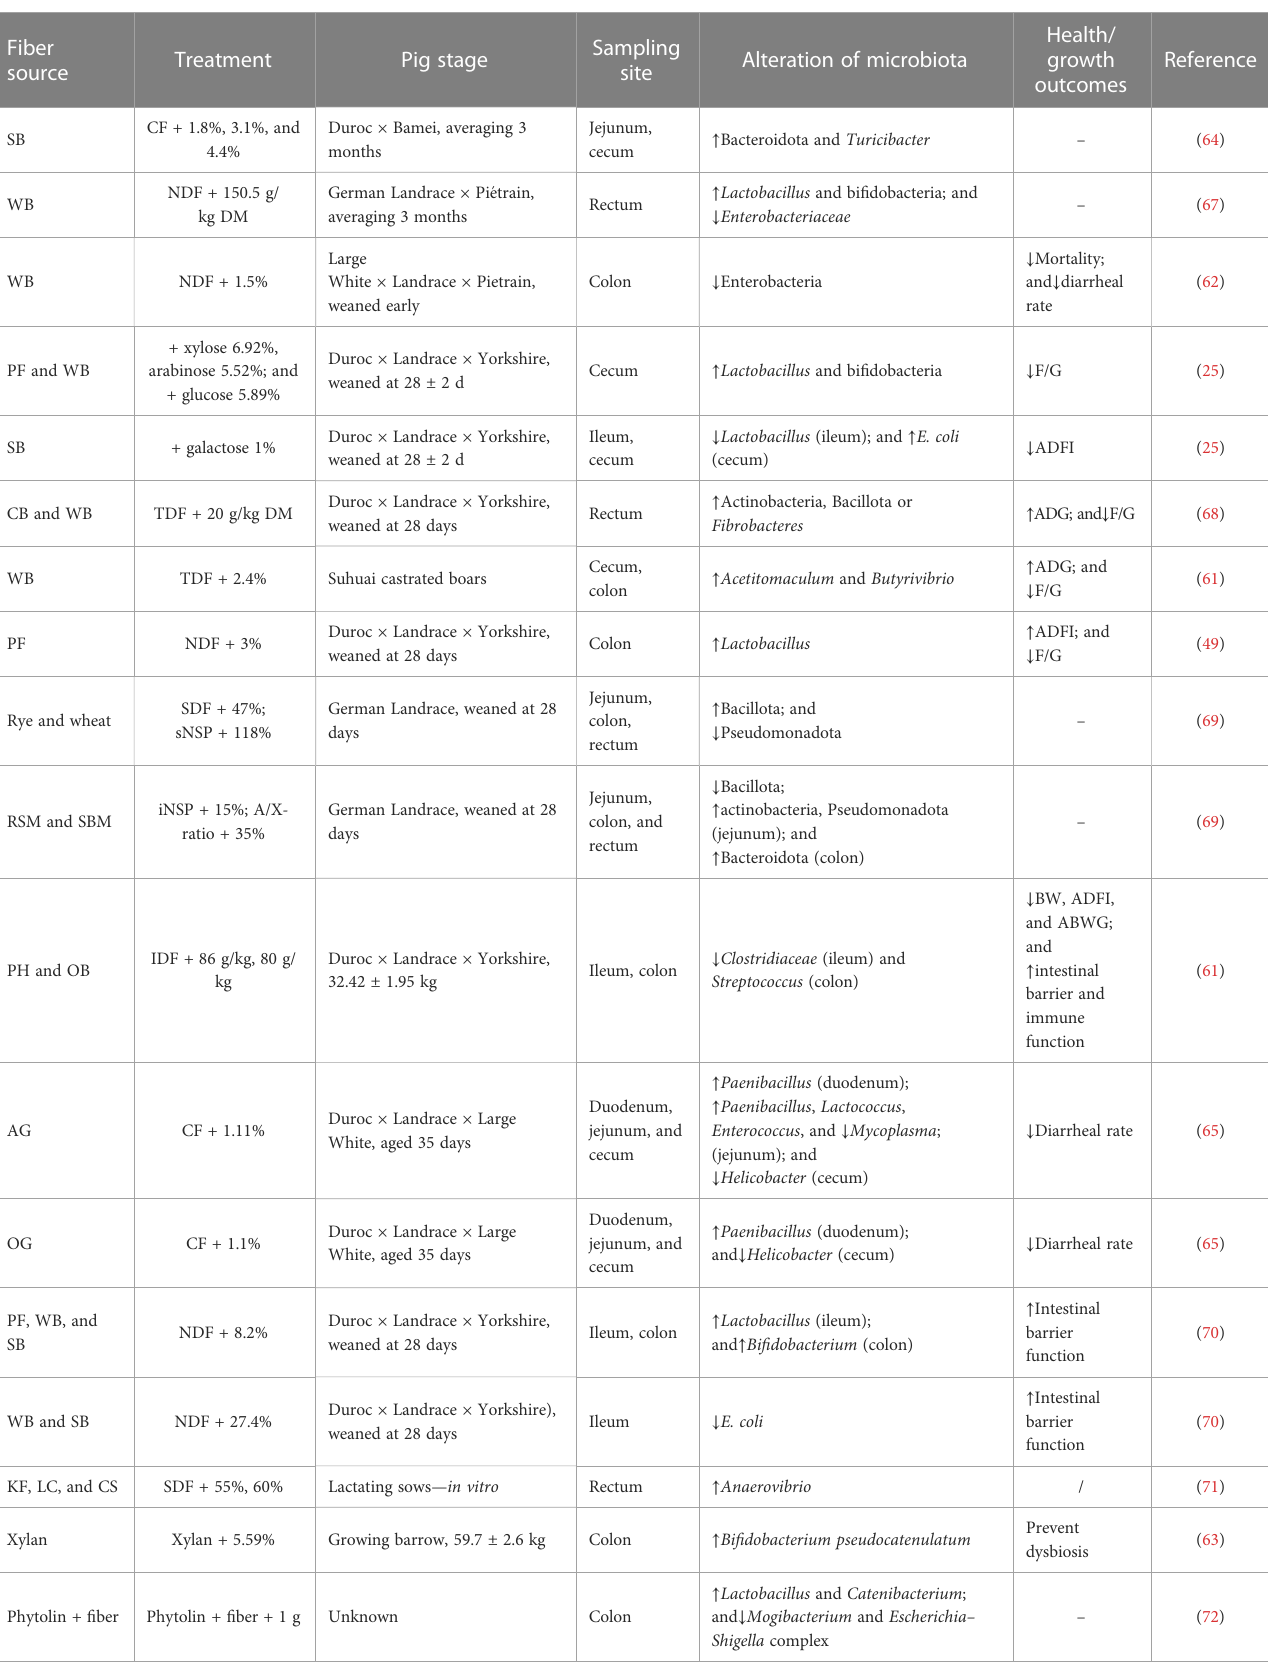
TABLE 2 Results of studies investigating the effect of fi ber on alternation of gut microbiota